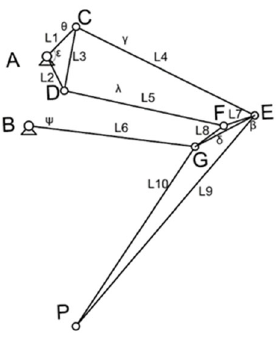
Figure 2. The modeling of the hindlimb linkage mechanism.